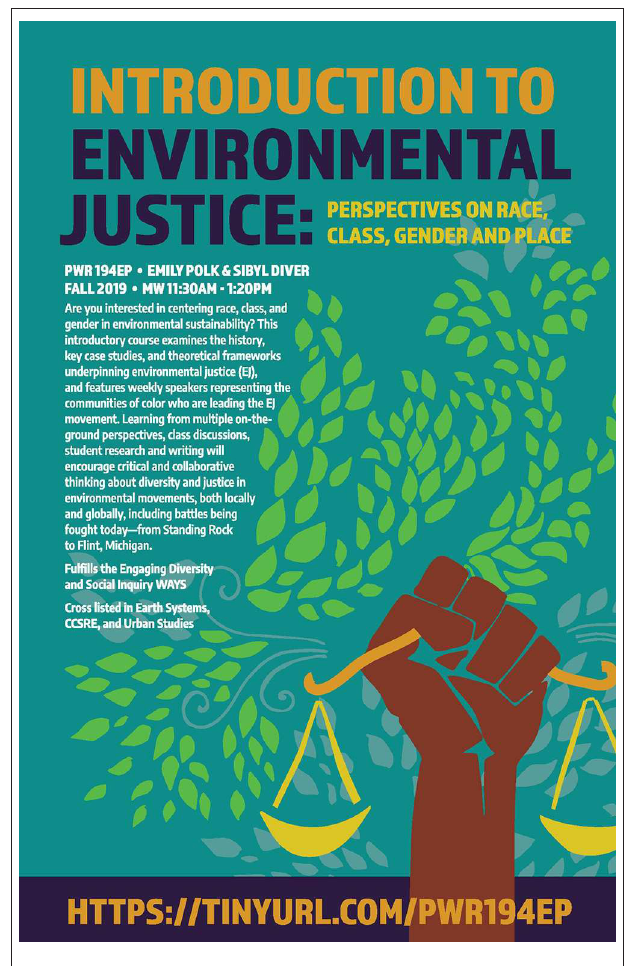
FIGURE 1 | Intro to Environmental Justice course poster, designed by Stephanie Muscat, Sibyl Diver, and Emily Polk. Used with